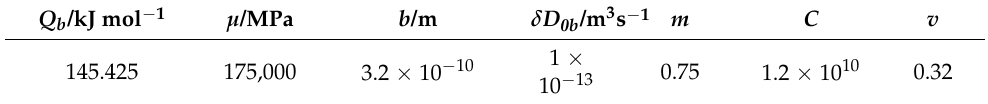
Table 1. Obtained appropriate values of material parameters in the simulation.